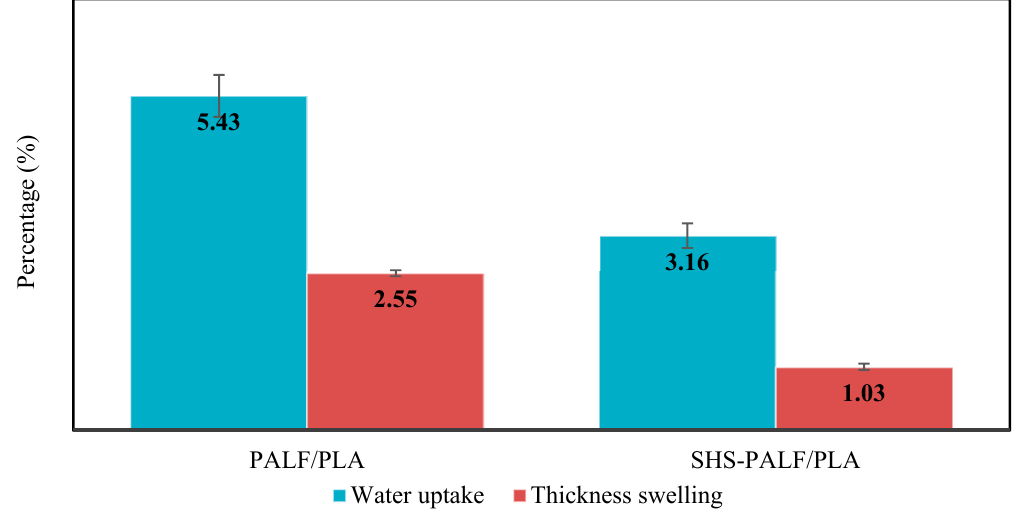
Figure 5. The water uptake and thickness swelling of PALF/PLA and SHS-PALF/PLA biocomposites.